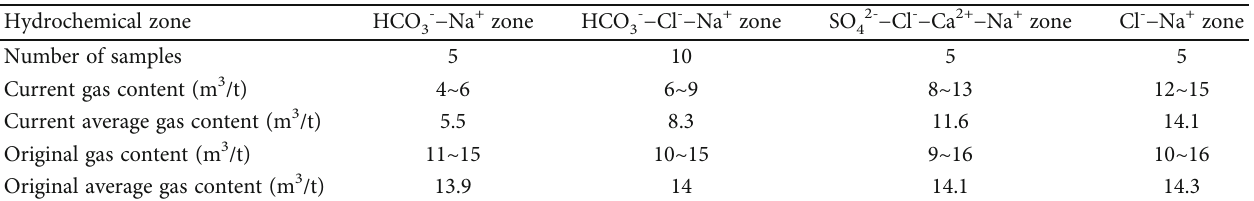
Table 5: Distribution of gas content in di ff erent hydrochemical zones of the No. 11 coal seam in the Hancheng mining area [44]. Hydrochemical zone